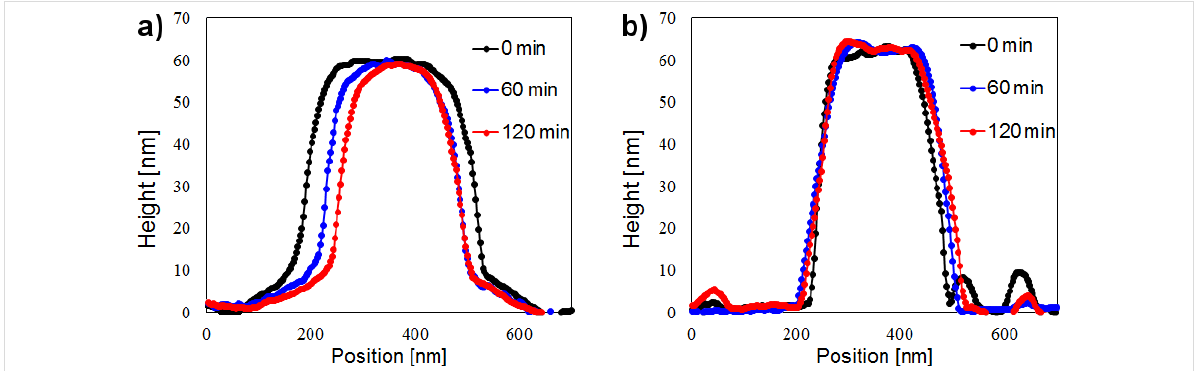
Figure 2: (a) Photoresist profile before (black) and after 60 min (blue) and 120 min (red) of 325 nm laser illumination under room conditions. (b) Same as (a) but with 405 nm laser illumination.